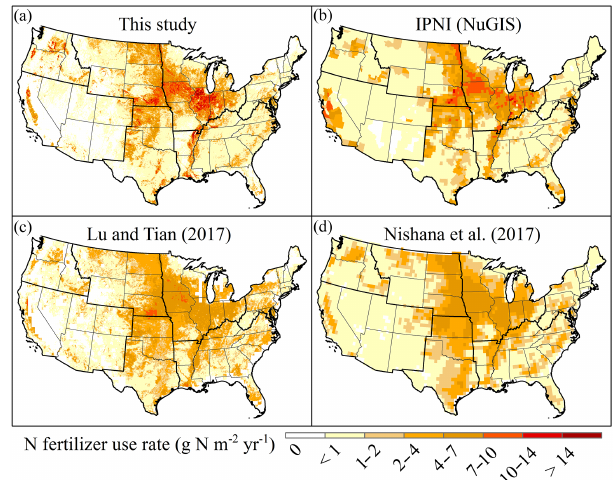
Figure 9. Comparison of N fertilizer use rates across the contiguous US in 2010. (a) This study; (b) IPNI (2018); (c) Lu and Tian (2017); and (d) Nishina et al.